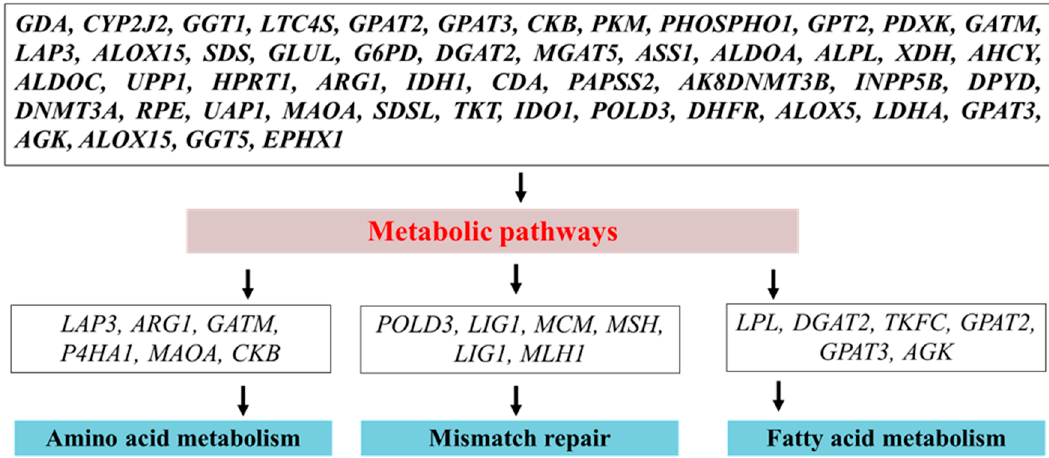
Figure 4. Folic acid supplementation mediates the essential genes linked to metabolic pathways (amino acid and fatty acid) and mismatch repair. For ease, the genes mainly involved in metabolic pathways, mismatch repair, fatty acid metabolism, and protein synthesis are summarized.